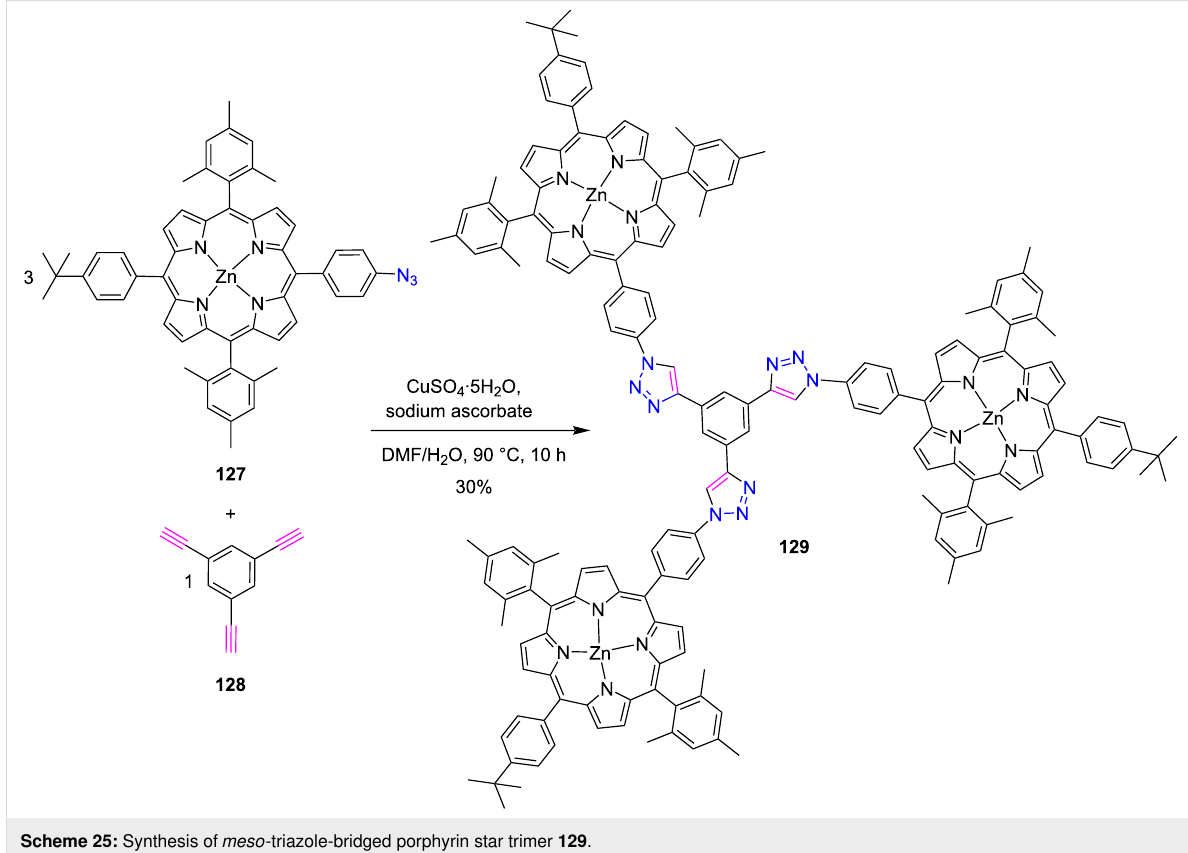
Scheme 25: Synthesis of meso -triazole-bridged porphyrin star trimer 129 .